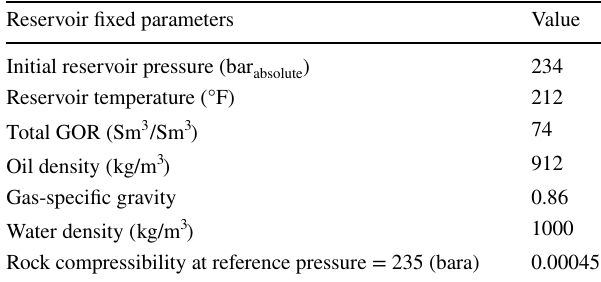
Table 1 Reservoir parameters used in reservoir simulation assumed constant during